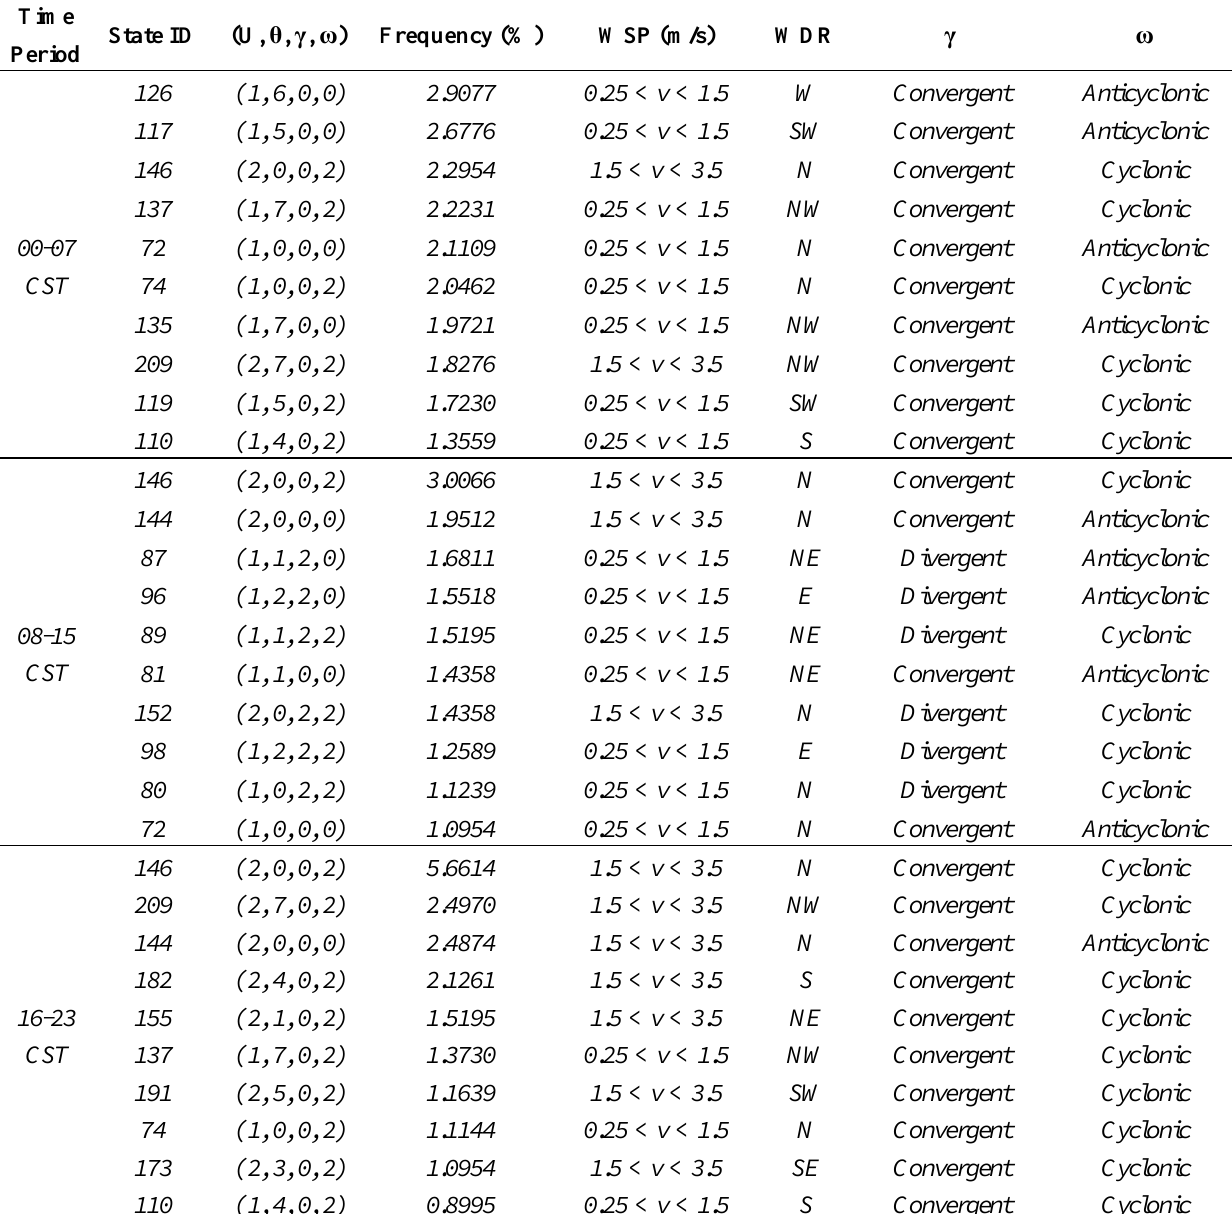
Table 10. First ten highest frequency DWS for the time periods 00-07 CST (early morning), 08-15 CST (morning and early afternoon), and 16-23 CST (late afternoon and